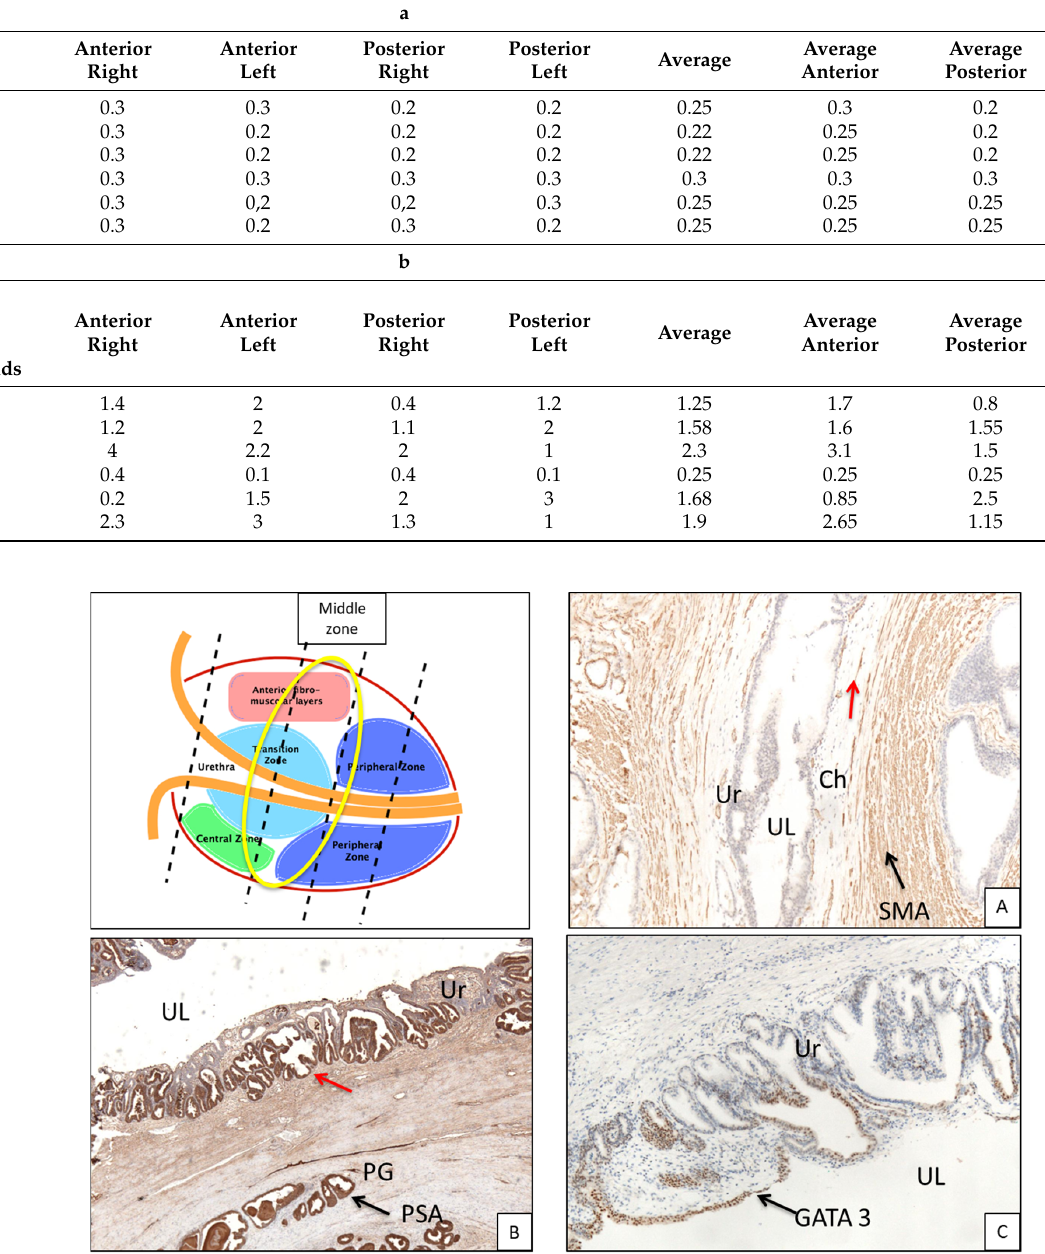
Figure 4. ( A ) Middle portion of urethra shows the presence of fibromuscular tissue right below the urothelium (arrow, smooth muscle actin immunohistochemistry, 4× magnification); red arrow shows small and thin muscle fibers progressively vanishing in chorion. ( B ) Immunohistochemical staining for PSA shows the presence of prostatic-type glands below the urothelial epithelium (arrow); notably, part of the urothelium is PSA-positive (red arrow, 4× magnification). ( C ) Immunohistochemical staining for GATA3 shows mixed positivity with PSA in urothelium (arrow, 4× magnification). UL, urethral lumen; Ur, urothelium; PG, prostatic glands; Ch, chorion; SM, smooth muscle; SMA, smooth muscle actin.